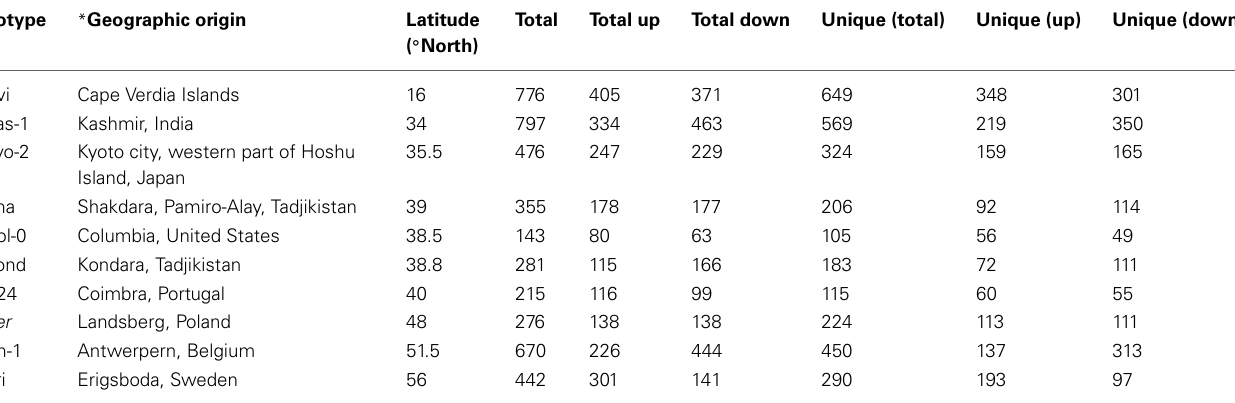
Table 1 | Summary of the ecotypes and their gene expression pattern during heat stress.